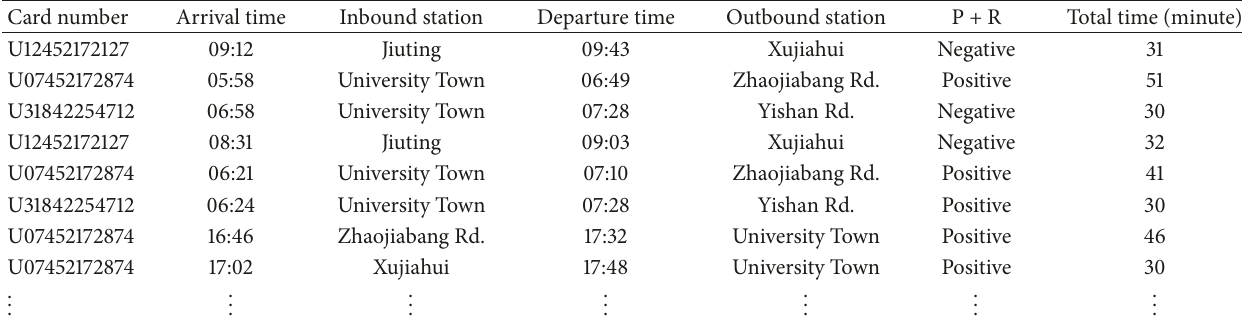
Table 2: The AFC passenger flow data of Shanghai Metro Line 16 (supplementary and correction).